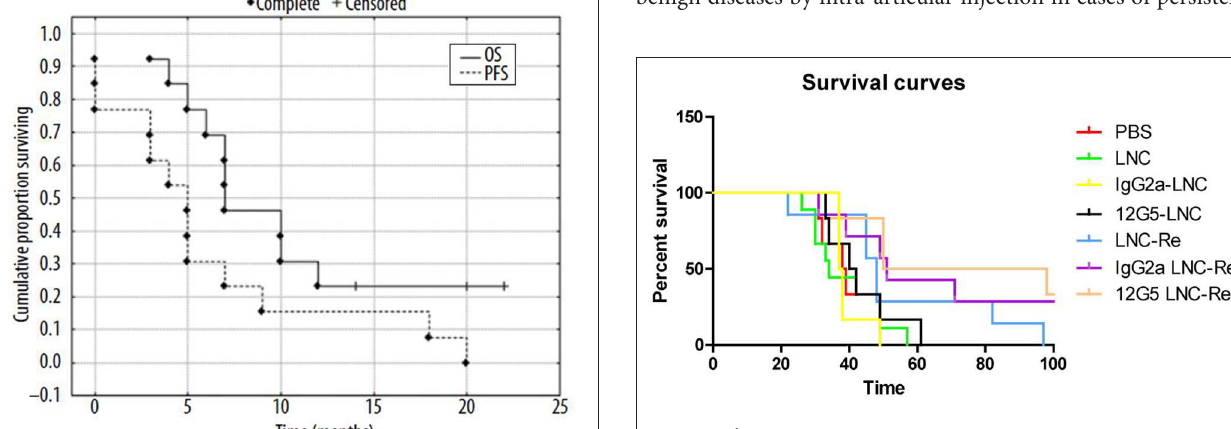
FIGURE 9 | Kaplan Meier curves of mice treated with saline solution (PBS), blank LNC, immuno-LNCs (12G5-LNCs and IgG2a-LNCs) and internal radiation therapies (LNC 188 Re, IgG2a-LNC 188 Re, and 12G5-LNC 188 Re) after single infusion through convection-enhanced delivery into CXCR4-positive brain tumors [from Séhédic et al. (214), available under the terms of the Creative Commons Attribution Non Commercial 4.0 (CC BY-NC